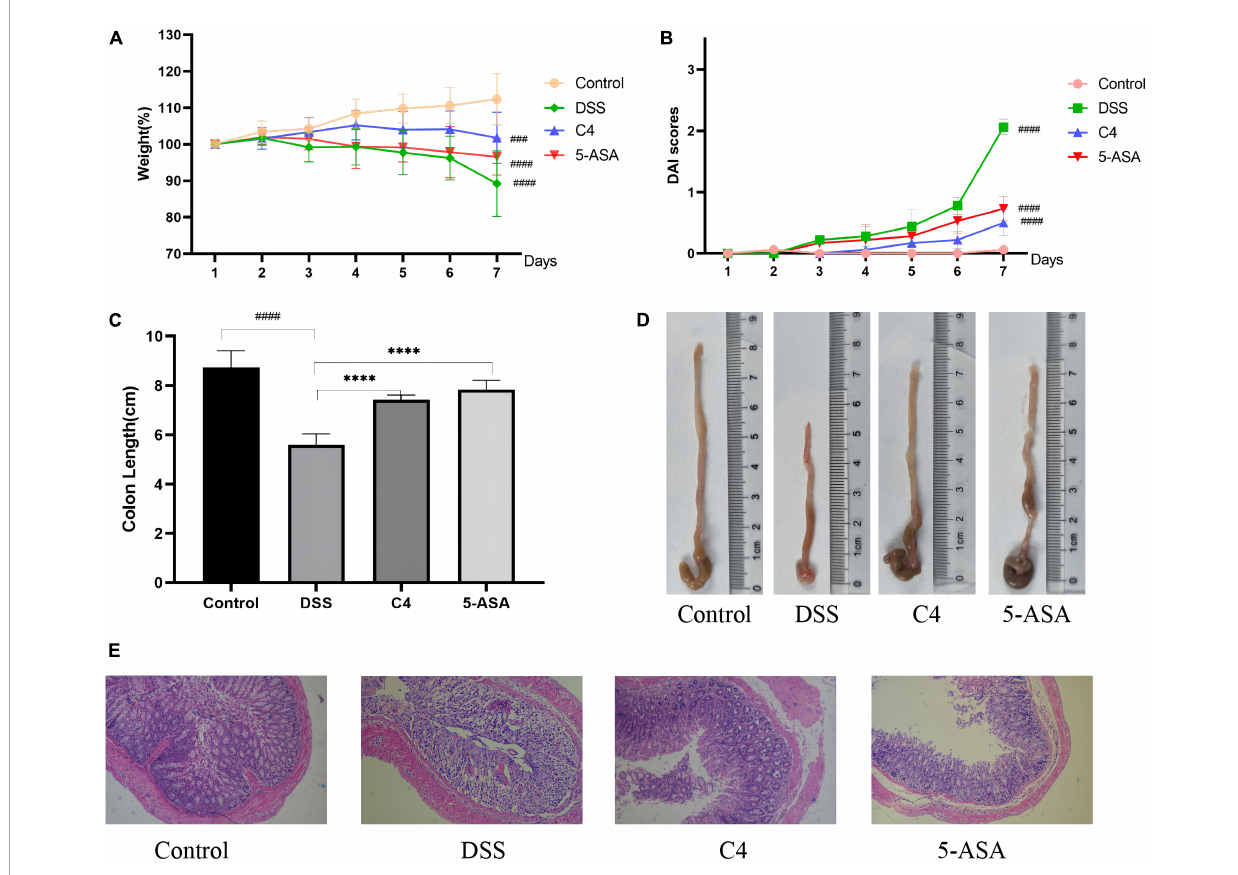
FIGURE1 Effect of the L. acidophilus C4 on the colon and weight in DSS-induced colitis mice model. Data are subjected to one-way ANOVA statistics and presented as mean ± standard deviation ( n = 6). (A) Changes in body weight. (B) Disease activity index scores. (C,D) Image of colon length. (E) Representative micrographs of H&E staining of colon tissue from the four groups of mice (400 fold magnification). **** P < 0.0001 vs. DSS group; ### P < 0.001 and #### P < 0.0001 vs. Normal group.